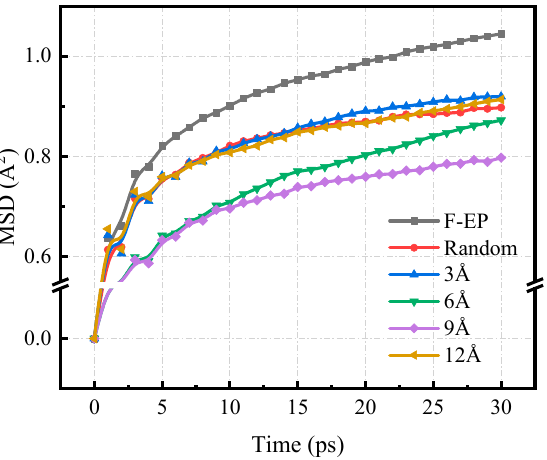
Figure 9. MSD of F ‐ EP composite systems with different FGO layer spacing.